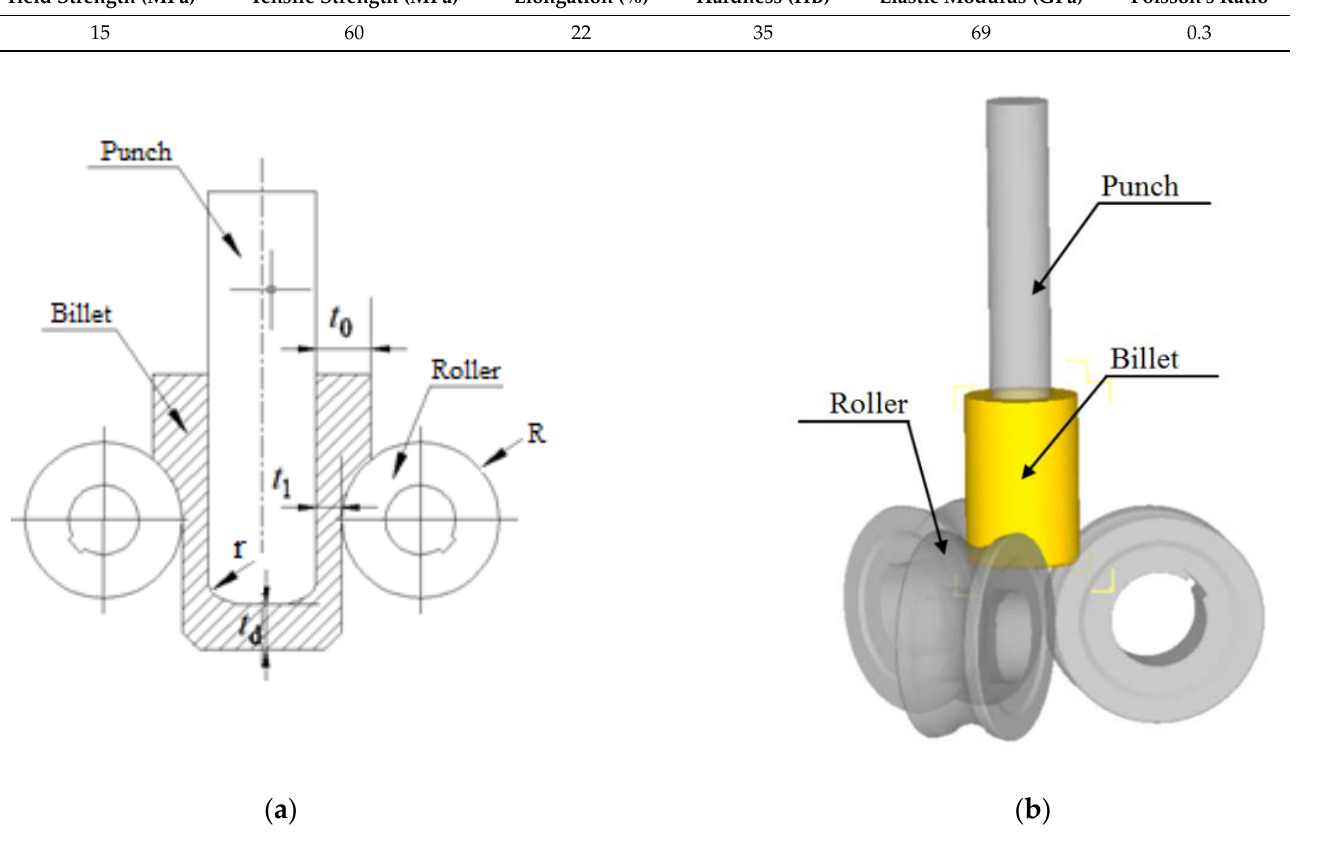
Figure 5. Simulation of roll forming: ( a ) schematic diagram; ( b ) simulation model. Table 1. Physical and mechanical properties of pure aluminum 1060.